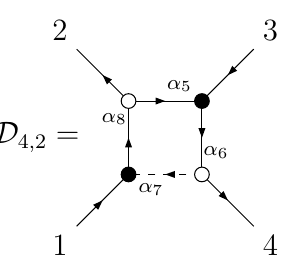
Figure 5 . On-shell diagram for 4-point amplitude with alternating